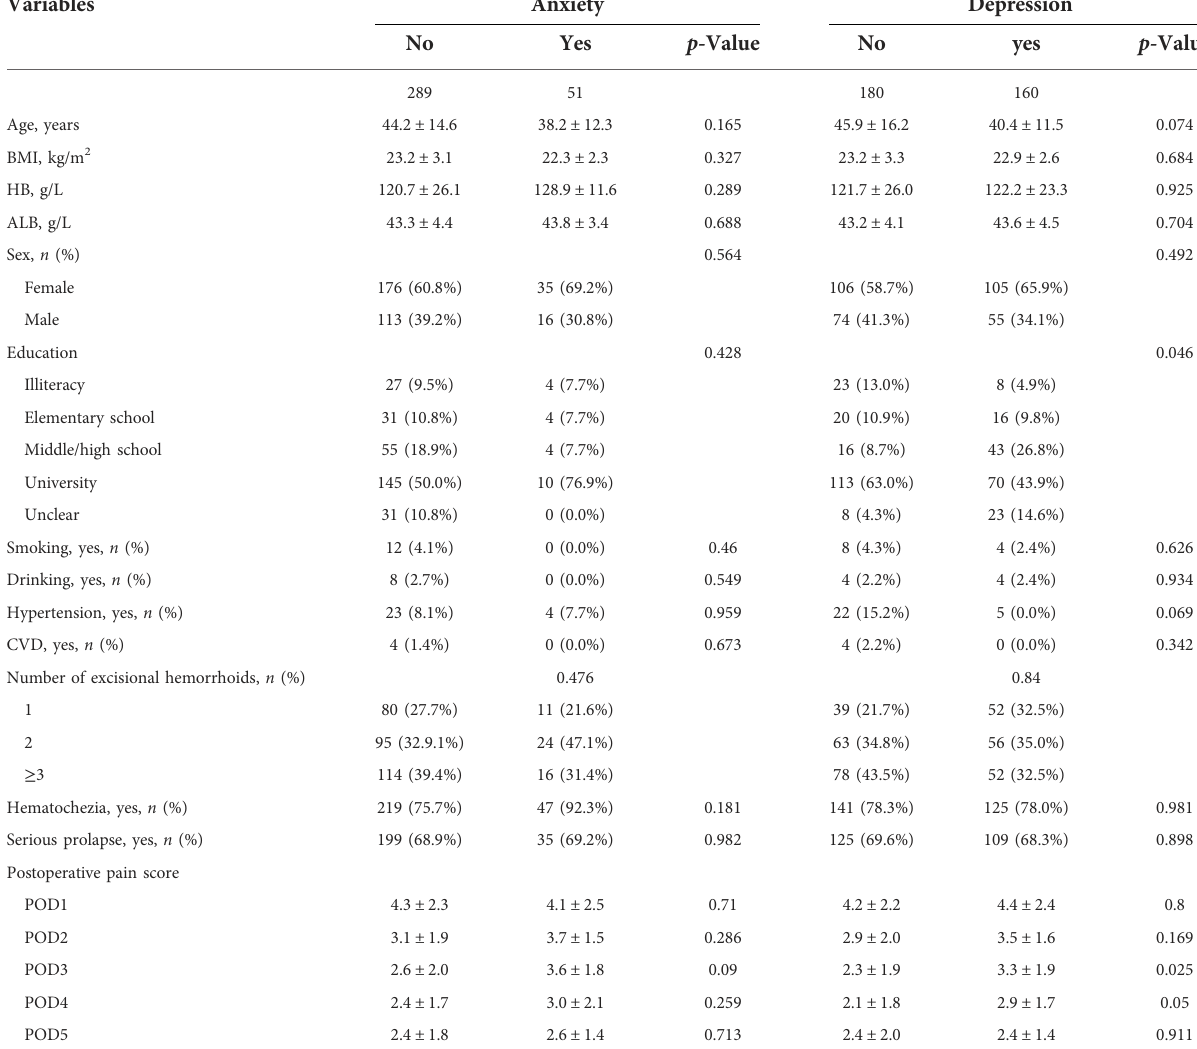
TABLE 2 Demographic, clinical data, and postoperative pain score according to anxiety or depression.